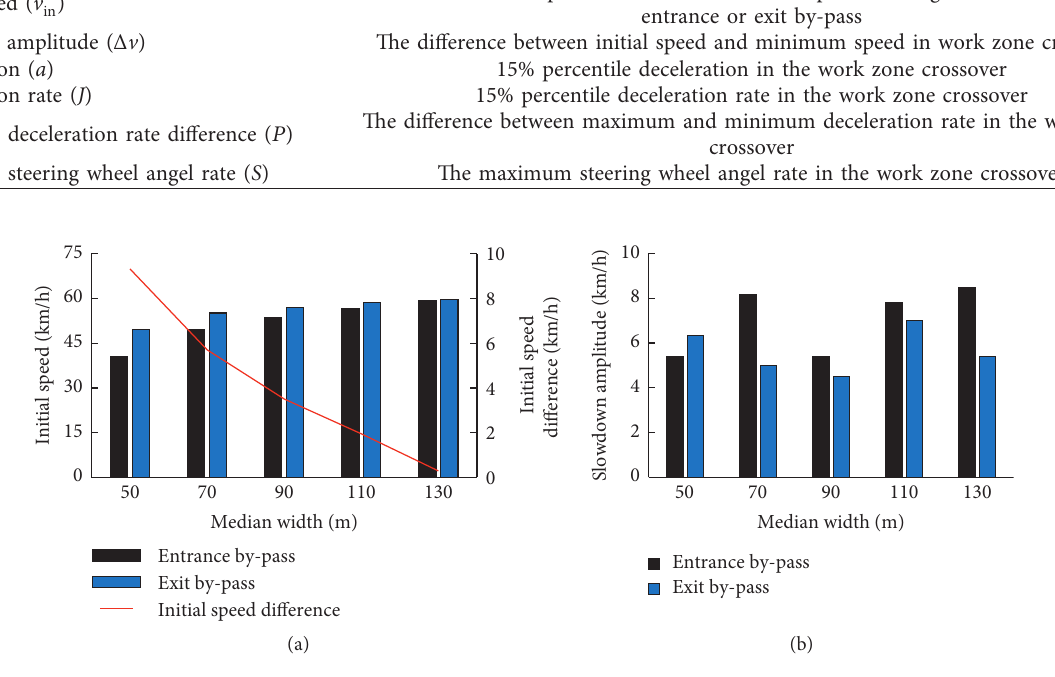
Figure 3: Speed parameters’ change with median width: (a) average initial speed; (b) slowdown amplitude.